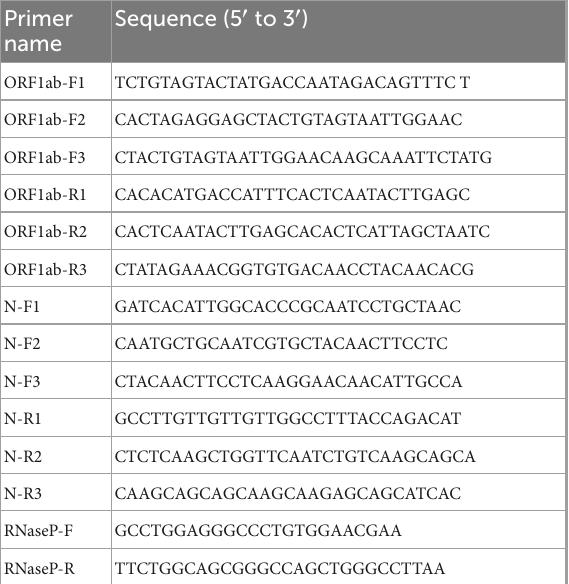
TABLE 1 Recombinase polymerase amplification (RPA) primer set design.